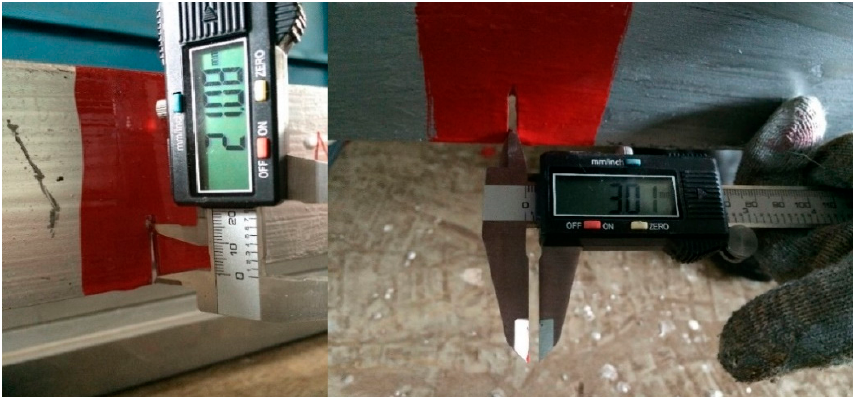
Figure 6. A general view of the crack. The right photo shows the width of the crack (around 0.003 m), and the left photo shows the height of the crack for delta = 30% (0.072 × 0.3 = 0.0216 m ≈ 0.021).